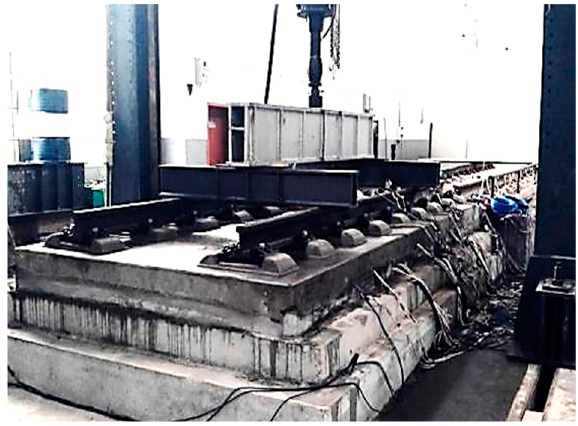
Figure 6. Loading